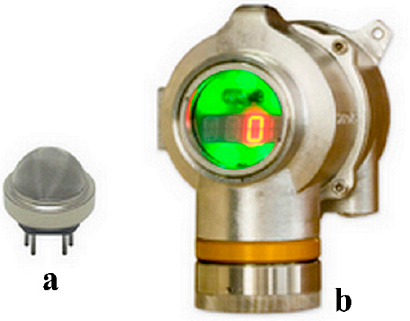
Figure 2. Images of the manufactured sensor ( a ) and of the DG-TT7 detection system from Simtronics SAS ( b ).